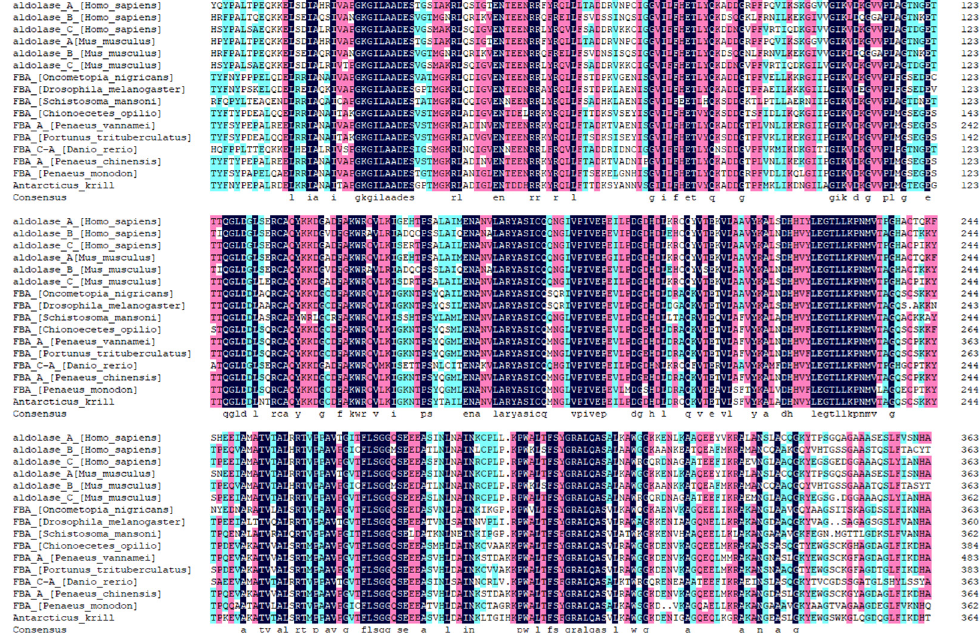
Figure 3. Multiple-sequence alignment of EsFBA and other reported fructose-1,6-bisphosphate aldolases. Conserved amino acids are highlighted in black.